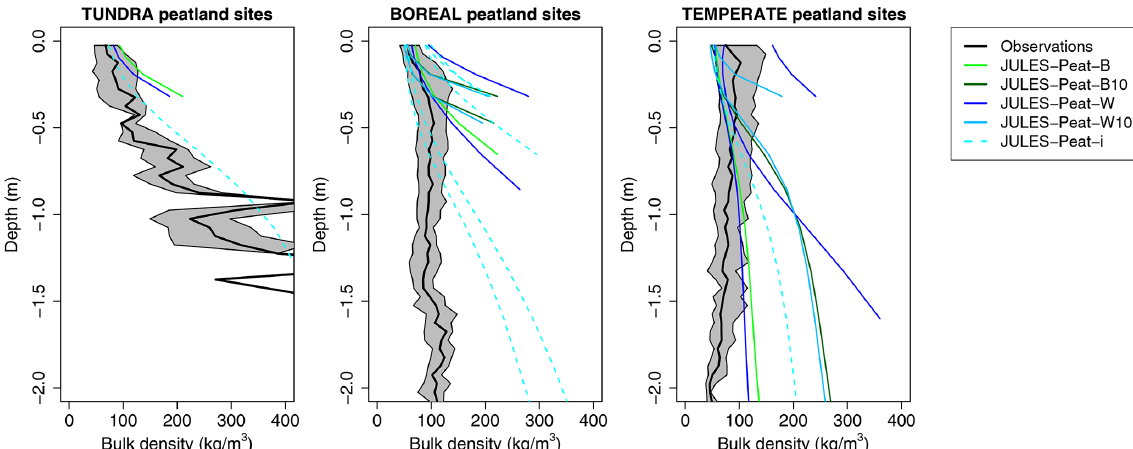
Figure 7. Evaluation of JULES-Peat bulk density profile against median profile from peat cores. The grey-shaded area shows the interquartile range. Only sites where the model simulates a sufficiently thick organic layer to classify it as peat ( > 15% carbon by mass for ≥ 39cm, see Sect. 3) are shown. The sites that are shown for each simulation are highlighted in bold in Table S4. Model profiles are cut off because only the organic layers are